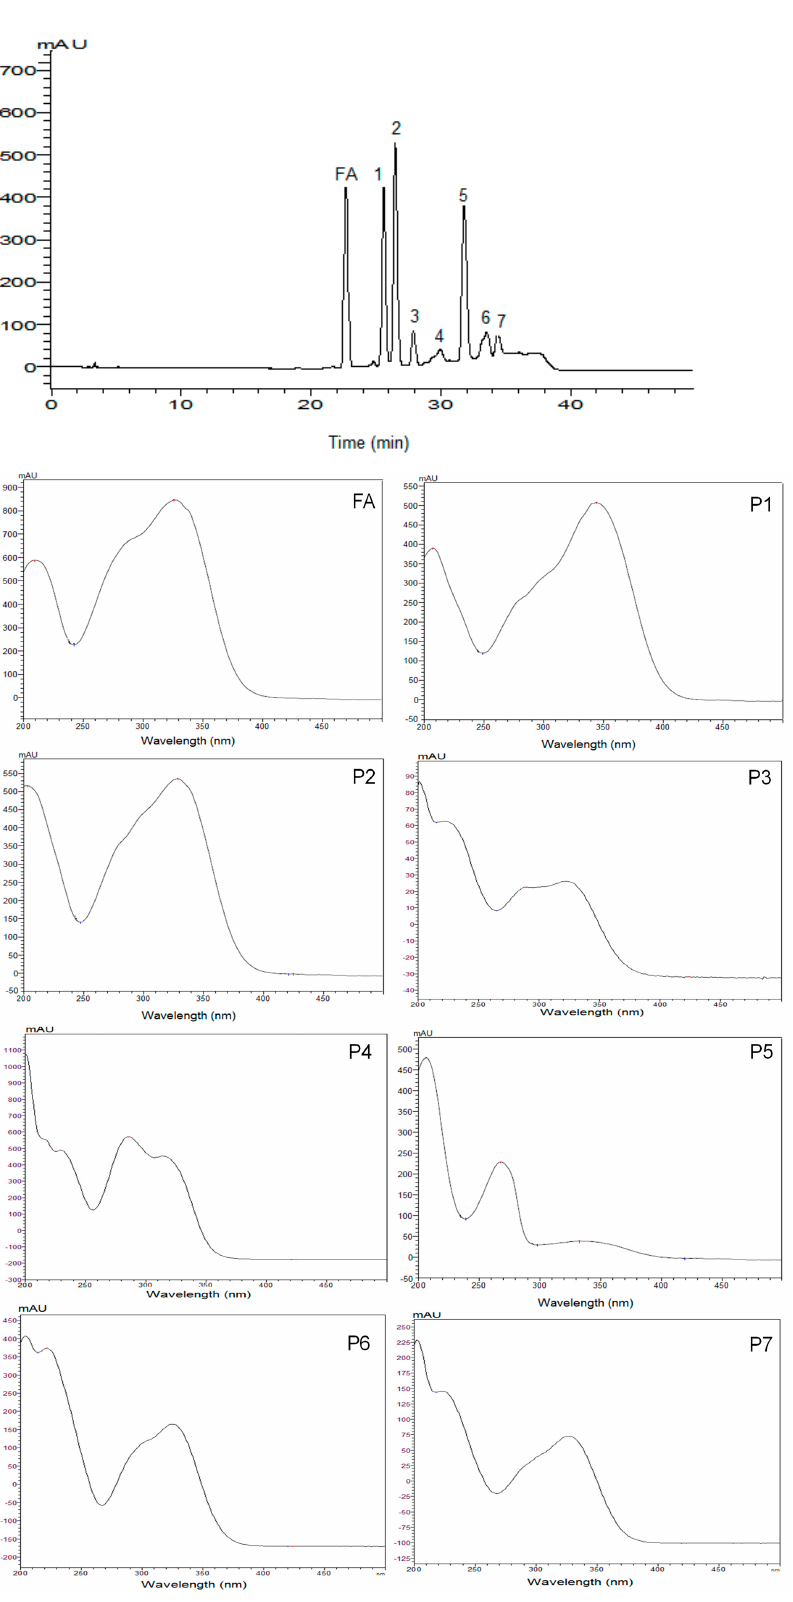
Figure 1. Reaction mixture chromatogram of FA after 3 h of reaction time and UV ‒ spectra collected by HPLC ‒ DAD of FA and its purified oxidation products. Column: RP-18, eluent: 80% acetonitrile and 20% water/TFA (20:0.03; v / v ), flow rate: 0.7 mL min − 1 . λ = 322 nm.